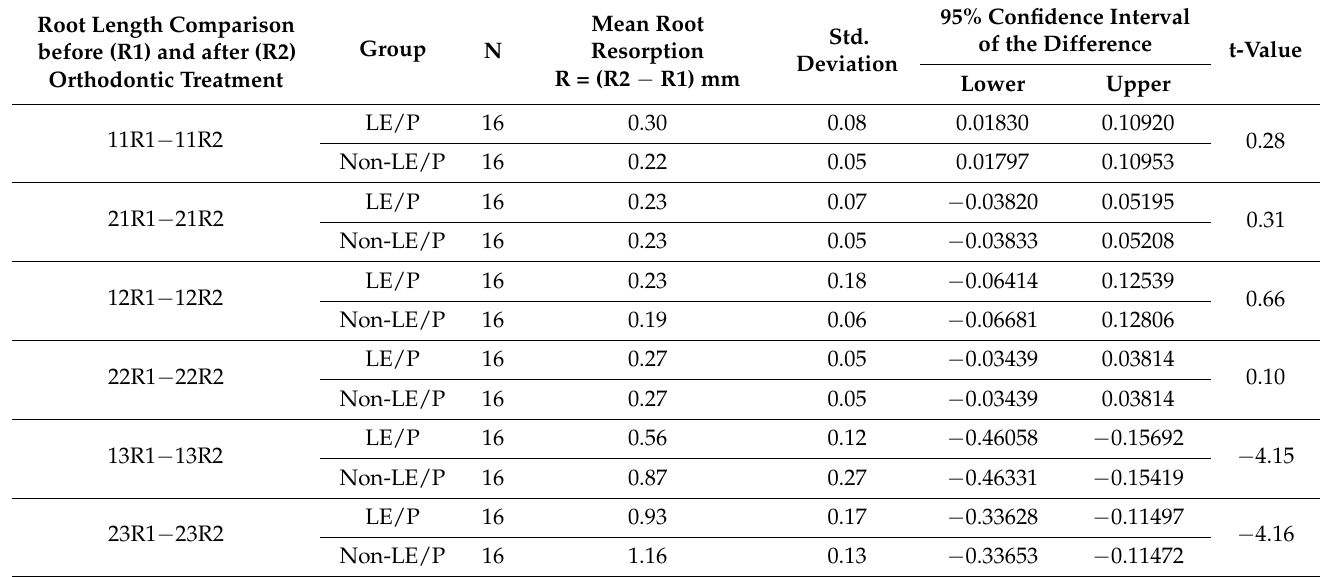
Table 2. Mean comparison of root resorption after orthodontic therapy in laser and non-laser groups. Root Length Comparison before (R1) and after (R2)